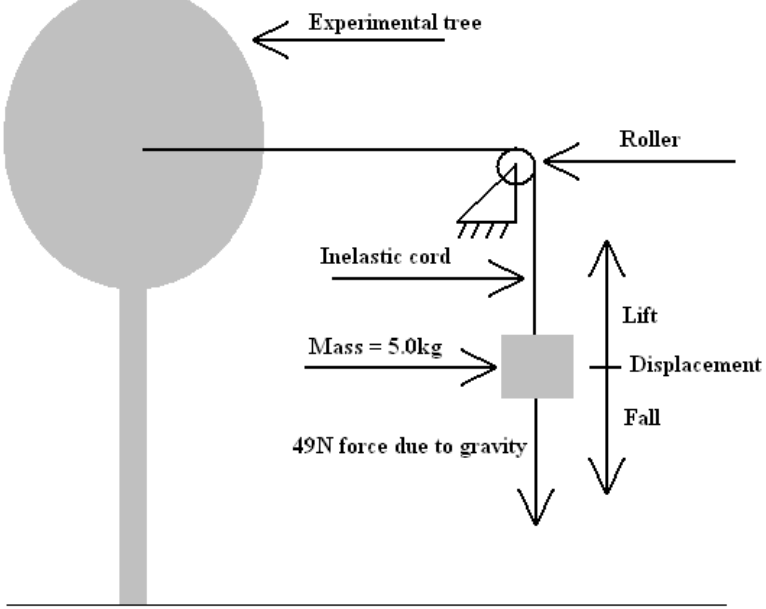
Figure 4. Tethered harvester experimental